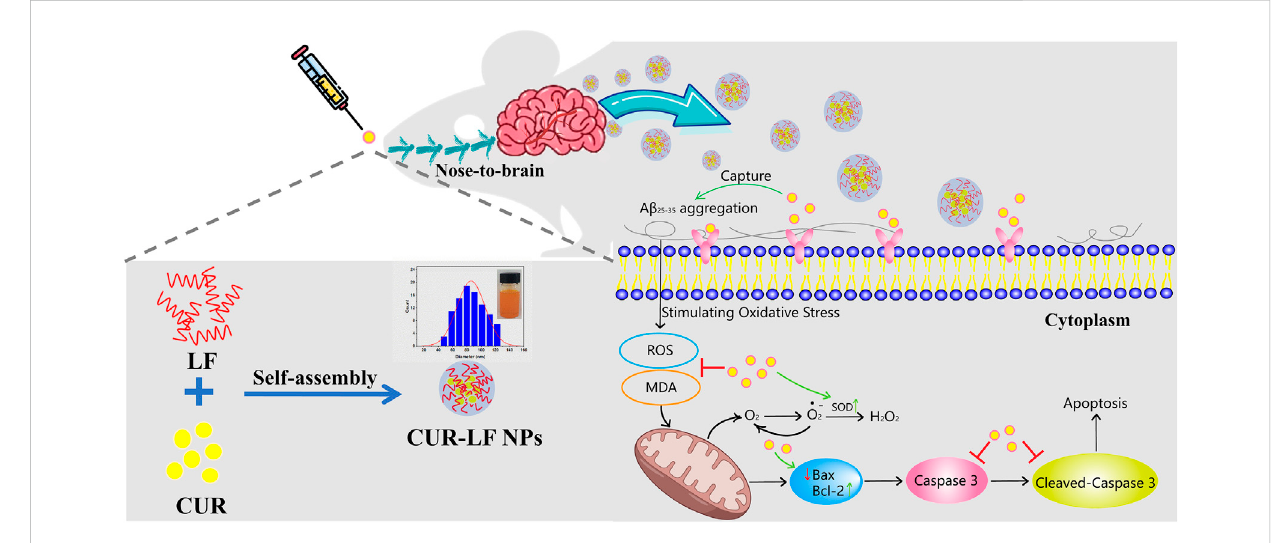
Schematic illustration of the preparation of curcumin-lactoferrin nanoparticles (CUR-LF NPs) and to evaluate the prospective and feasibility for neuroprotection via intranasal